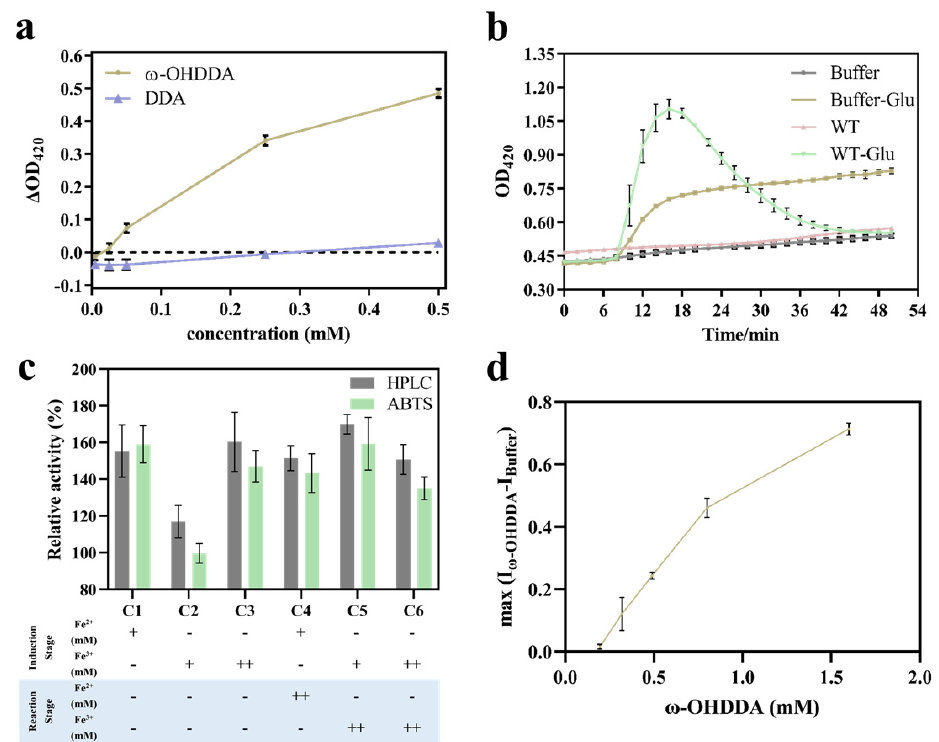
Figure 3. Establishment and optimization of the high-throughput screening method. ( a ) DDA and ω -OHDDA standard reagents were determined by ABTS colorimetry. ∆ OD 420 , the maximum difference between the absorbance of the experimental group and the background at λ = 420 nm, namely, Δ OD 420 = max (I E − I B ). ( b ) Results of ABTS colorimetry for the reaction systems with and without cyp153a-ncp (WT). The reaction was performed with a 50 g cell wet weight (cww)/L of WT cells in sodium phosphate buffer (100 mM, pH 8.0) with or without 1% ( w / v ) D-glucose. ( c ) Effect of Fe 2+/3+